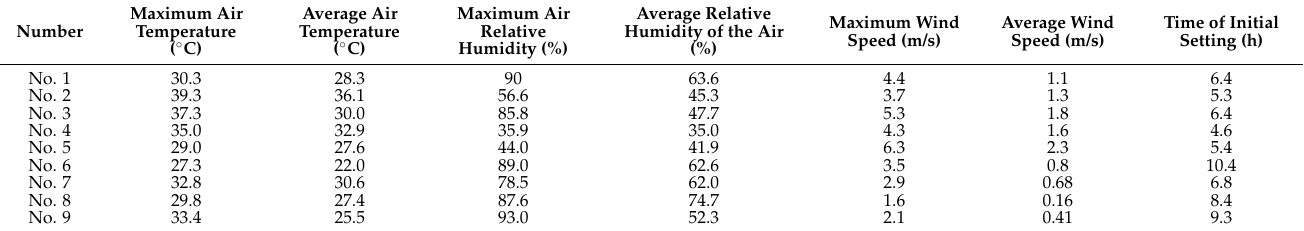
Table 7. Data samples of environmental variables on storehouse surface.